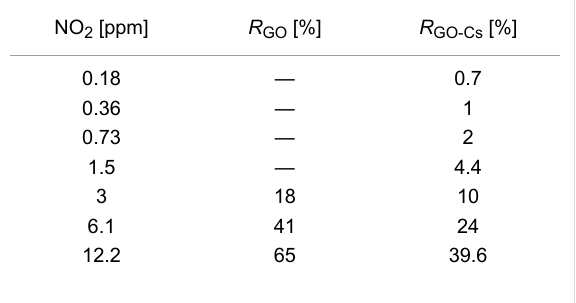
Table 1: Comparison of the GO and GO-Cs response towards NO 2 with different